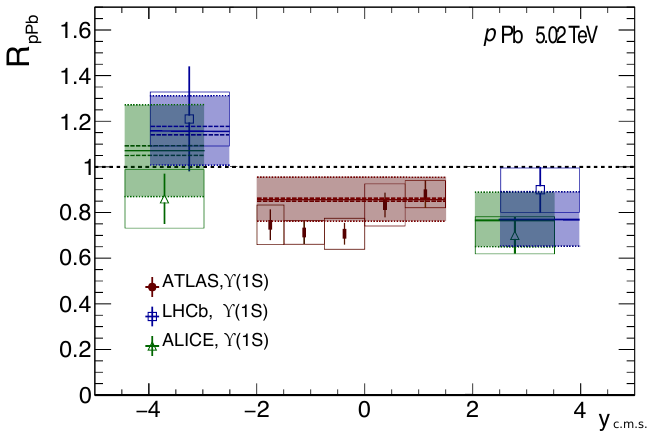
Figure 3 . The R (cid:7)(1 S ) vs rapidity compared to the LHC data [9, 41, 42]. The uncertainty from p Pb the (cid:27) co (cid:0) (cid:7) (cid:12)t (dashed line) and from the nCTEQ15 shadowing (dotted line along with the colored band) are shown separately.